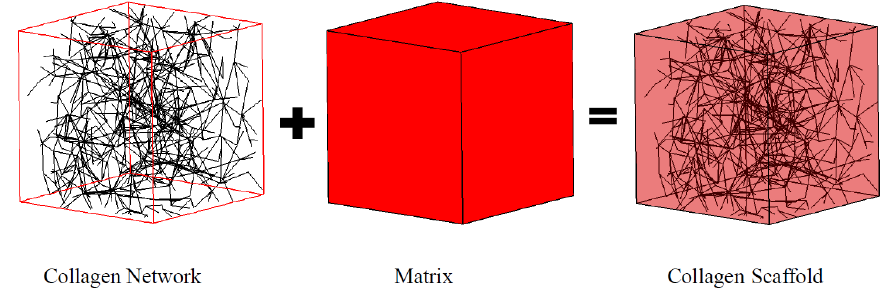
Figure 1. Collagen scaffold represented by the coupled fiber-matrix model.